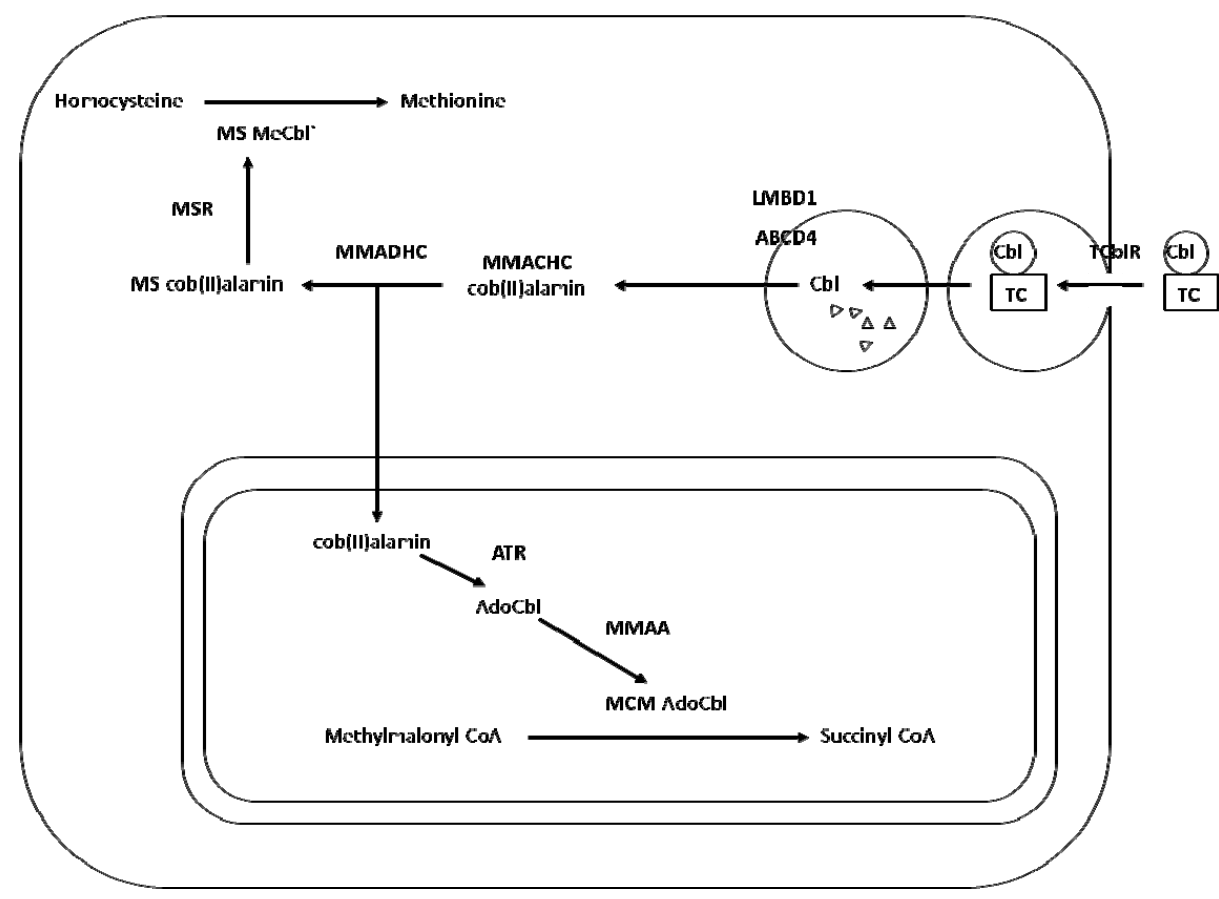
Figure 1. Intracellular processing of cobalamin. Cobalamin (Cbl) bound to transcobalamin (TC) is taken up by endocytosis and converted to methylcobalamin (MeCbl), which is required for activity of the cytoplasmic enzyme methionine synthase (MS) or adenosylcobalamin (AdoCbl), which is required for activity of the mitochondrial enzyme methylmalonylCoA mutase (MCM). TCblR, TC receptor; MSR, methionine synthase